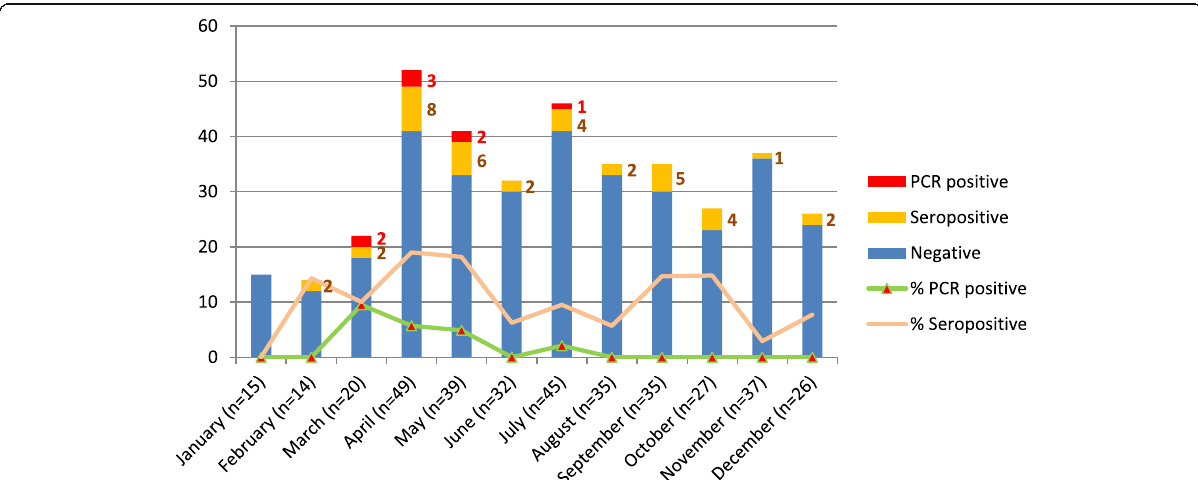
Fig. 4 Nested RT-PCR and antibody results of specimens from P. lylei bats ( N = 374) collected monthly in 2012. Number of bats captured each month (indicated), and number of PCR-positive and serology-positive bats are indicated in blue, green and yellow in the bar graph, respectively. Percent of PCR-positive and seropositive bats are indicated by green and pink line,